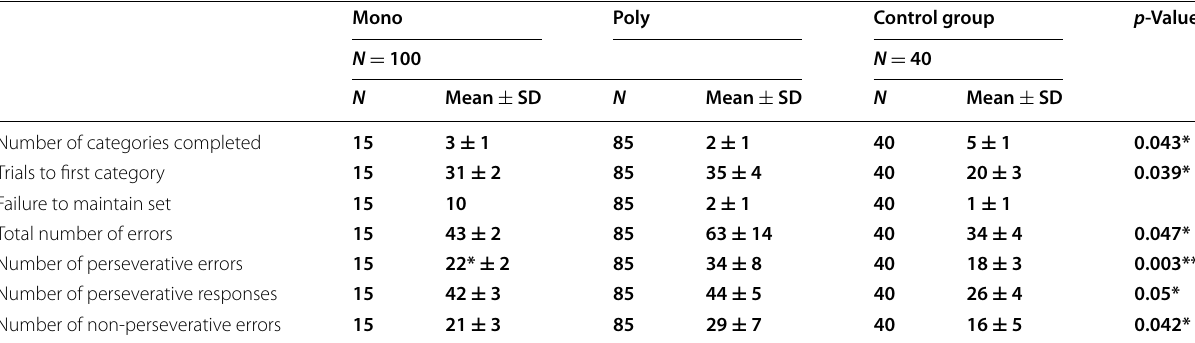
* p -value < 0.05 significance. ** p -value < 0.01 significance. Shows that mono and polysubstance case groups had lower mean than control group as regard number of category completed and higher mean than control group as regard other WCST domains; the difference between mono and polysubstance users’ cases and control groups had statistically critical ( p 0.05). Polysubstance use case group shows higher mean than mono substance use group as regard number of perseverative = errors; the difference between two groups had statistically critical ( p